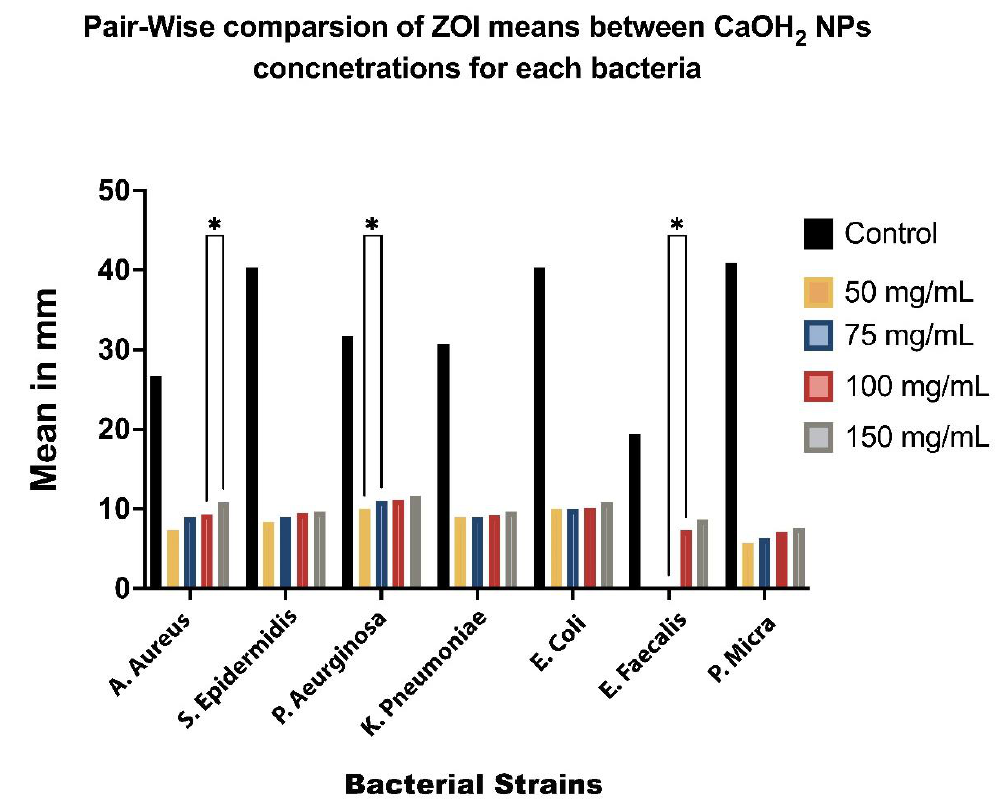
Figure 2. Pair-wise comparison between C-CaOH 2 NPs concentrations for each bacterial strain. Only S. Aureus , P. Aeruginosa , and E. Faecalis showed statistical significance between concentrations (marked with an asterisk).